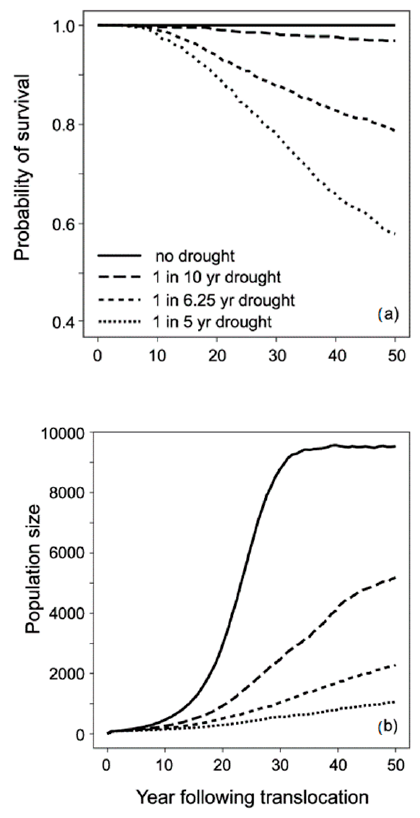
Figure 3. Performance over 50 years for 100 translocated L. fasciatus to DHI with drought frequencies of 1 in 5 years, 1 in 6.25 years, 1 in 10 years, or no drought. ( a ) Survival probability. ( b ) Population